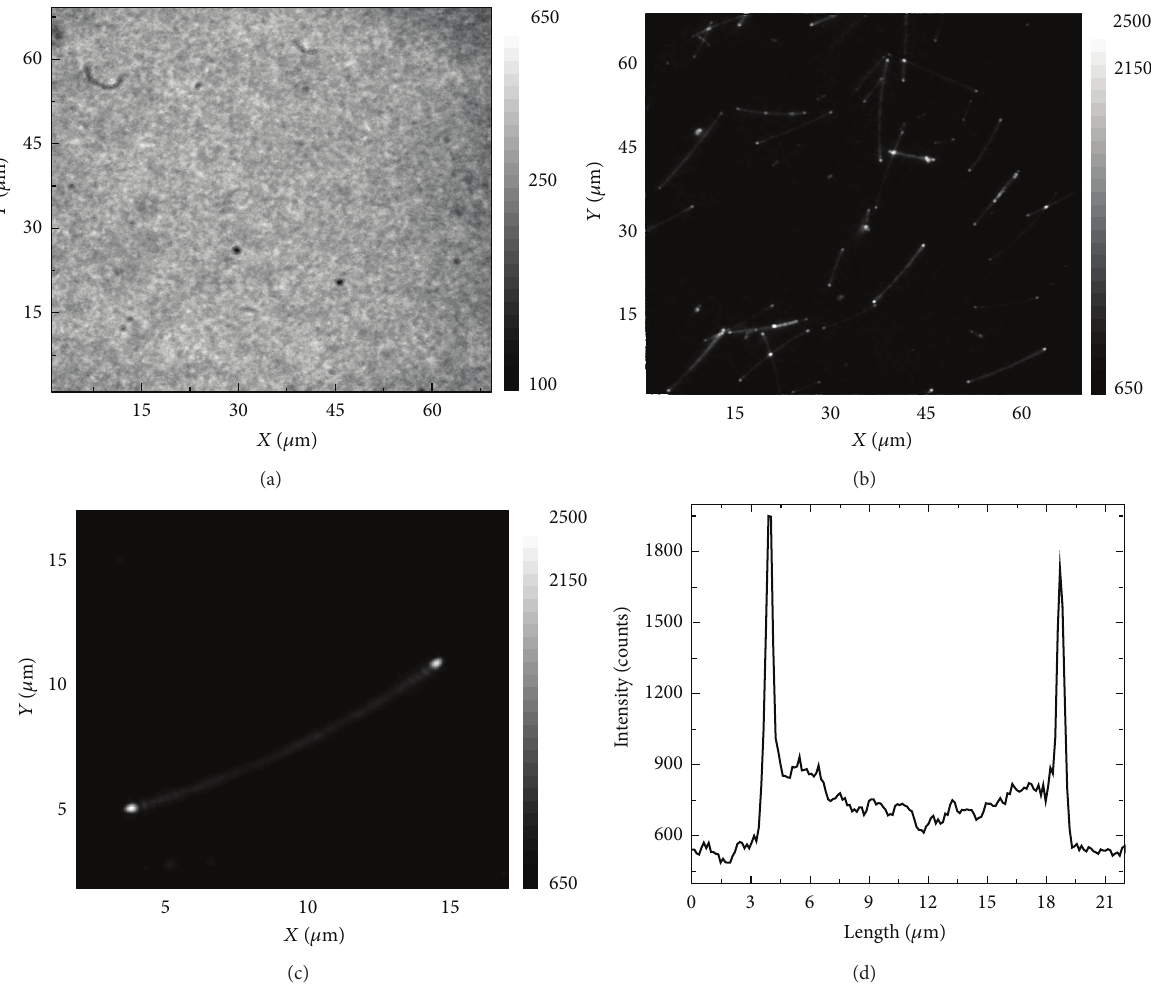
Figure 4: Fluorescence intensity maps obtained using wide-field microscopy for the PCP complexes excited with 480nm light. (a) Reference sample with PCP complexes only, (b) PCP complexes mixed with silver nanowires, (c) zoom into a single, well-separated AgNW, and (d) emission intensity distribution along a single